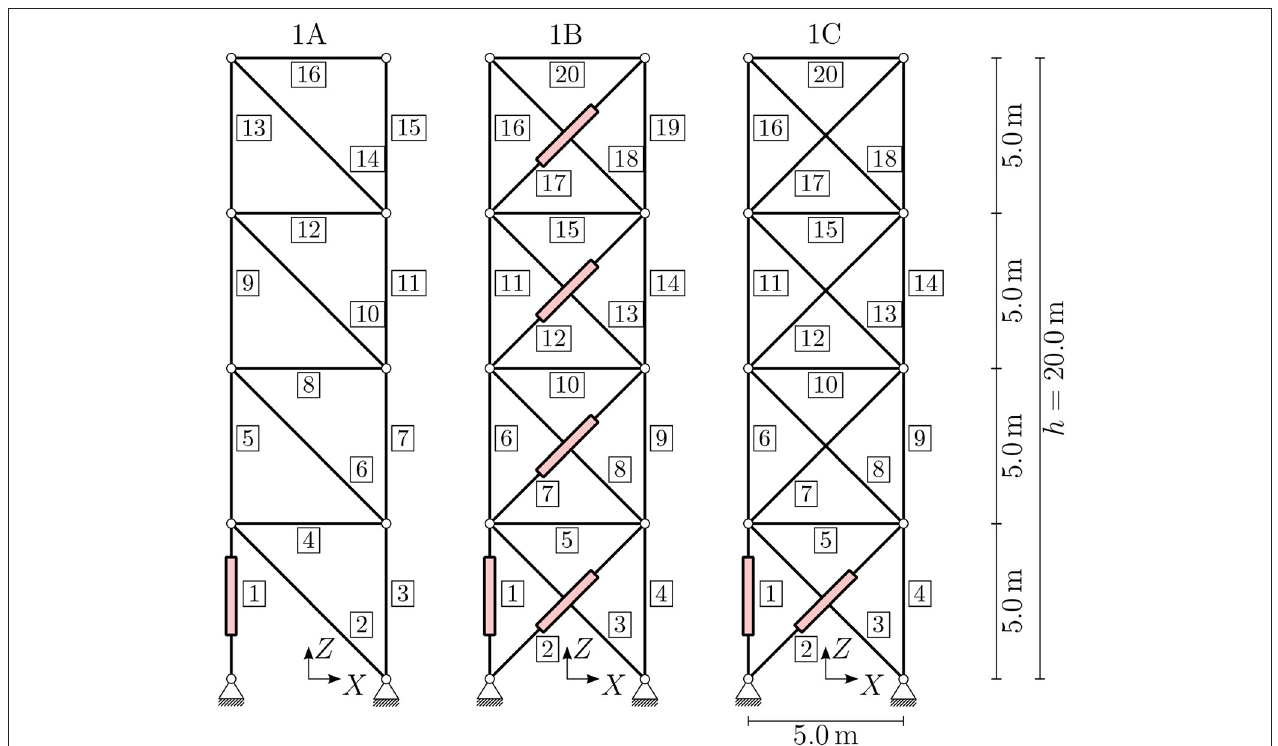
FIGURE 2 | Example 1, truss design: investigated variants with dimensions and actuator